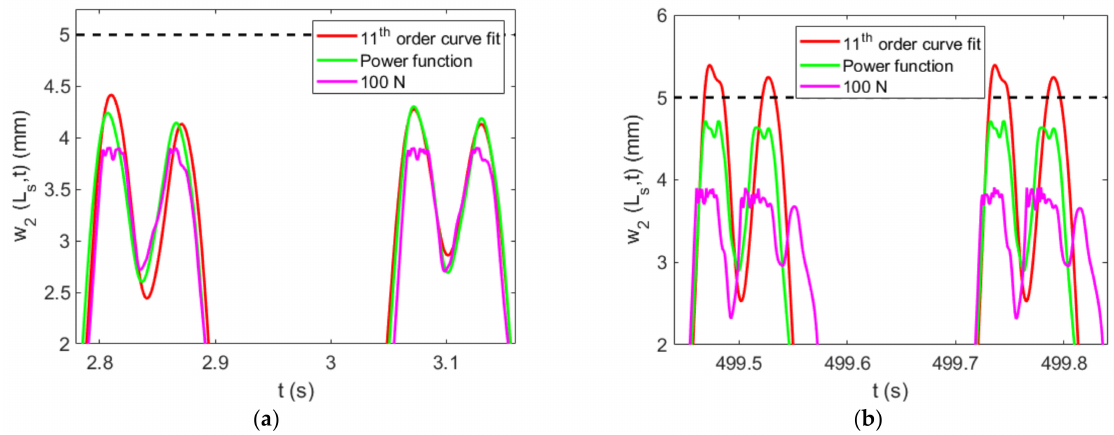
Figure 6. Various forcing methods for dynamic gaps smaller than 1 mm during the ( a ) transient and ( b ) steady states.